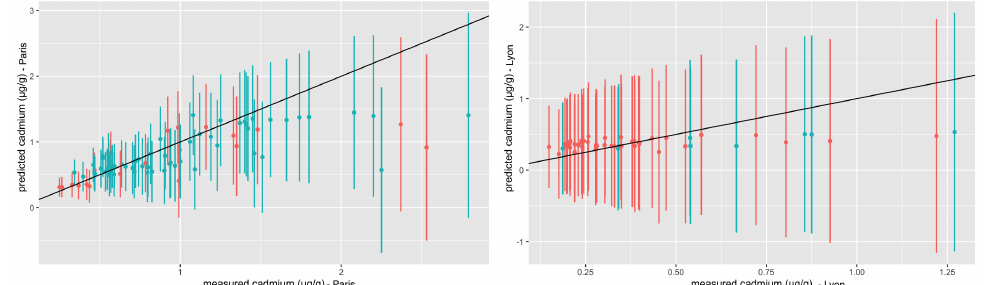
Figure 7. Predictions of Cd in mosses by the model taking into account experimental errors and CHIMERE errors, as well as their confidence intervals. On the left (resp. right): prediction of Cd in Paris (resp. Lyon) mosses by the model trained on Paris (resp. Lyon) mosses. The line corresponds to the line y = x . Red (resp. Blue) is used when the support of the corresponding moss is a wall (resp. a grave).